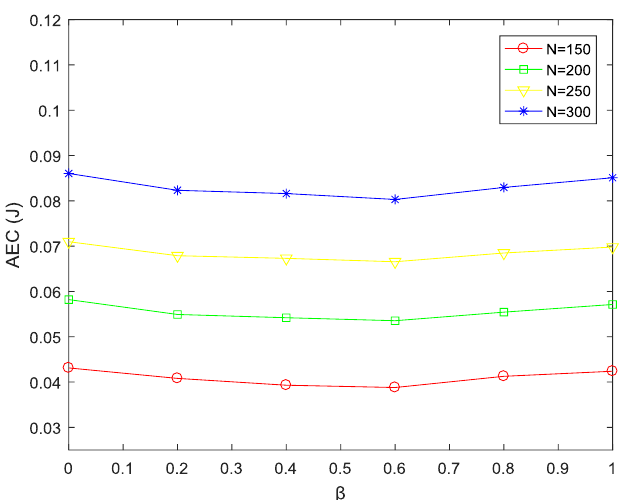
Figure 4. AEC varying with β at different network sizes.